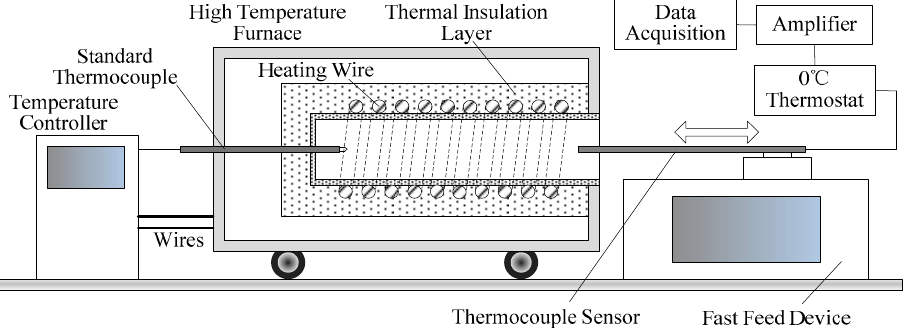
Figure 2. Measurement system for time constant of the thermocouple based on high temperature furnace.